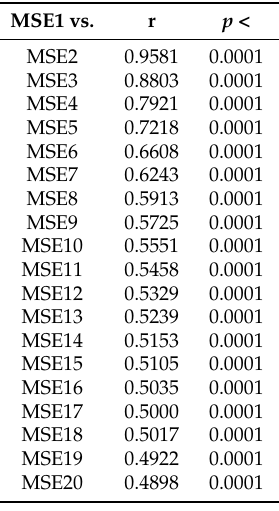
Table A19. Spearman correlations between MSE1 versus MSE2–MSE20 in positive